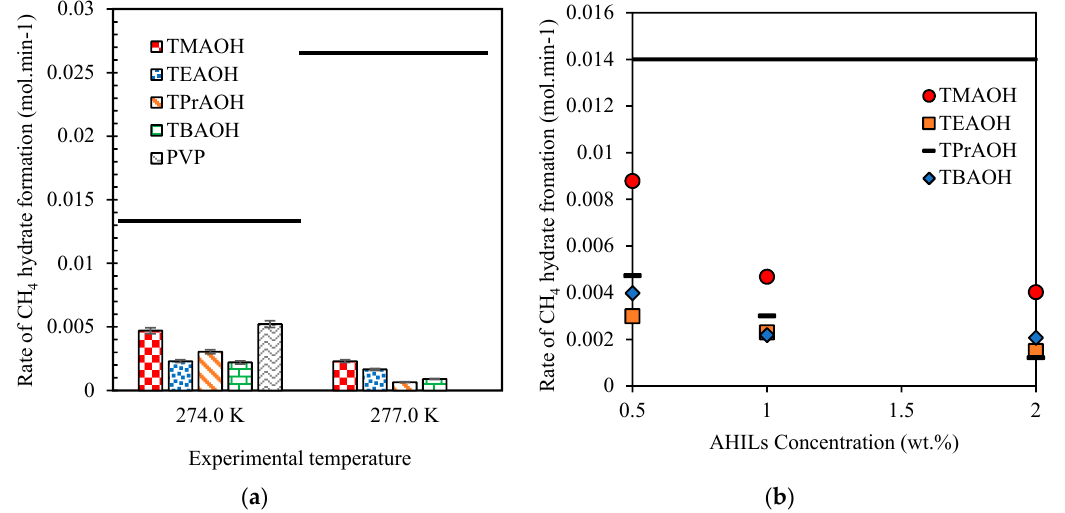
Figure 5. ( a ) E ff ect of AHILs on the measured CH 4 hydrate initial rate of formation at di ff erent experimental temperatures at 1 wt.%; ( b ) E ff ect of AHILs concentrations on the CH 4 hydrate initial rate of formation at 274.15 K; The black line symbolizes pure water values; No hydrate formation was observed for PVP at 277.0 K.